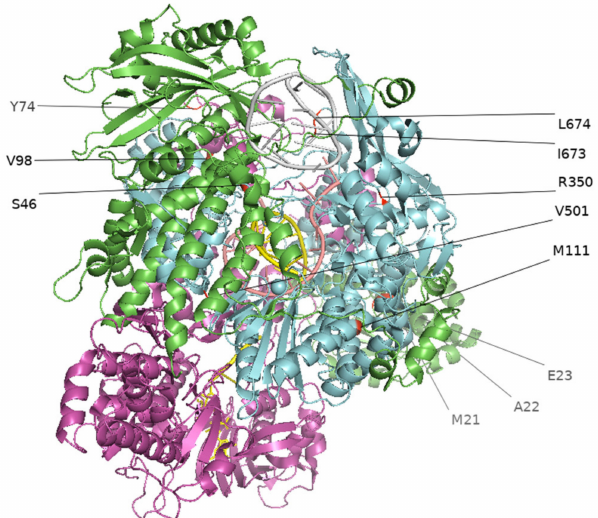
Figure 1. Cell-adapted mutations in the RNA polymerase complex of influenza B virus isolates (2019–2020). Mutations at the RNA polymerase complex (PB1, PB2, PA) are visualized in PyMOL using the 6QCT protein structure from the Protein Data Bank (PDB, https://www.rcsb.org/, accessed on 27 June 2021). Green represents PA, blue represents PB1, purple represents